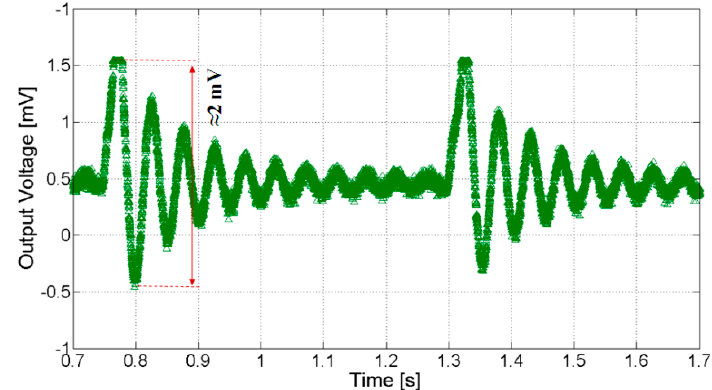
Figure 7. The output voltage of the BC in the presence of a mechanical step.